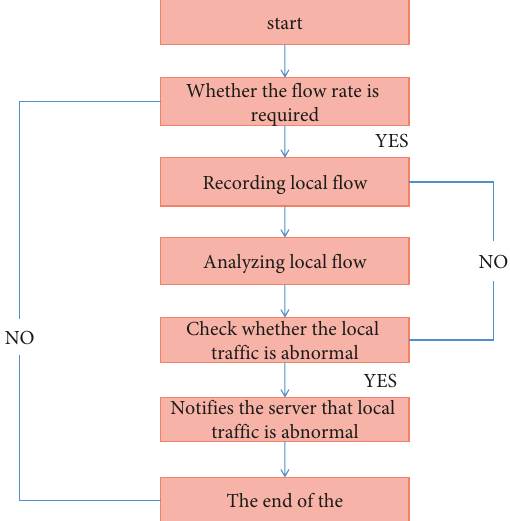
Figure 5: Flowchart of controlled host traffic audit.